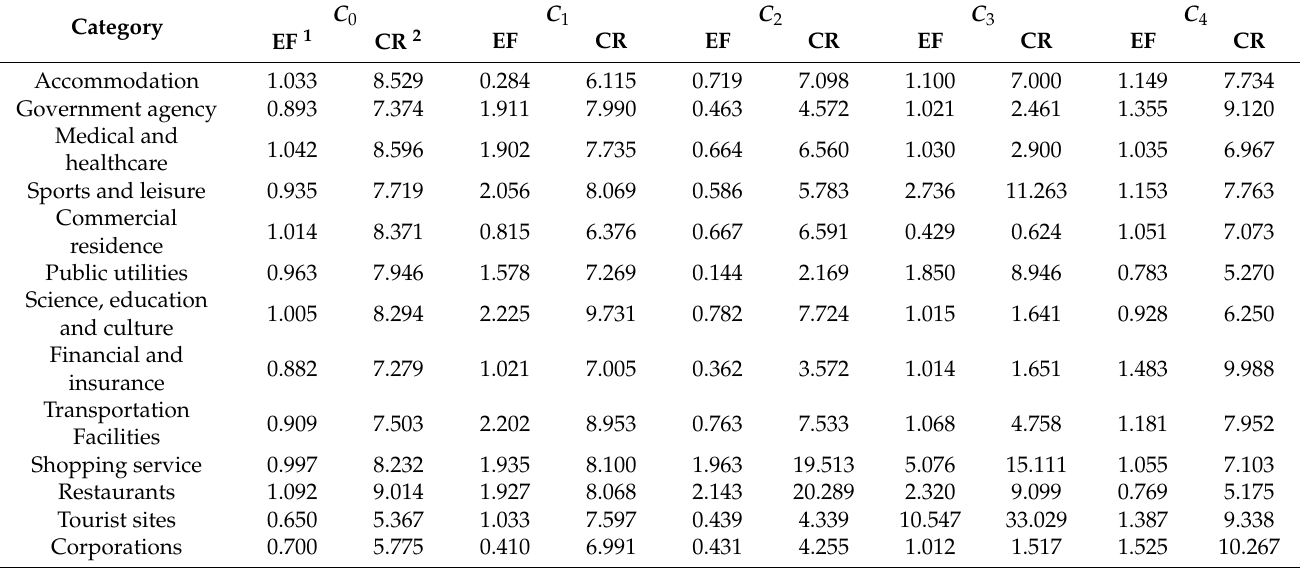
Table 4. CR and EF values of